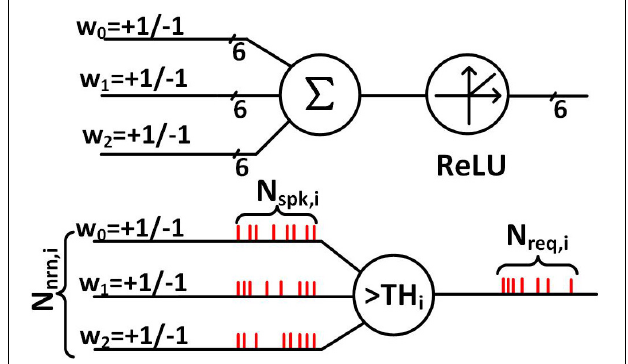
FIGURE 6 | Binary coding in a BNN and spike-rate coding in an SNN.